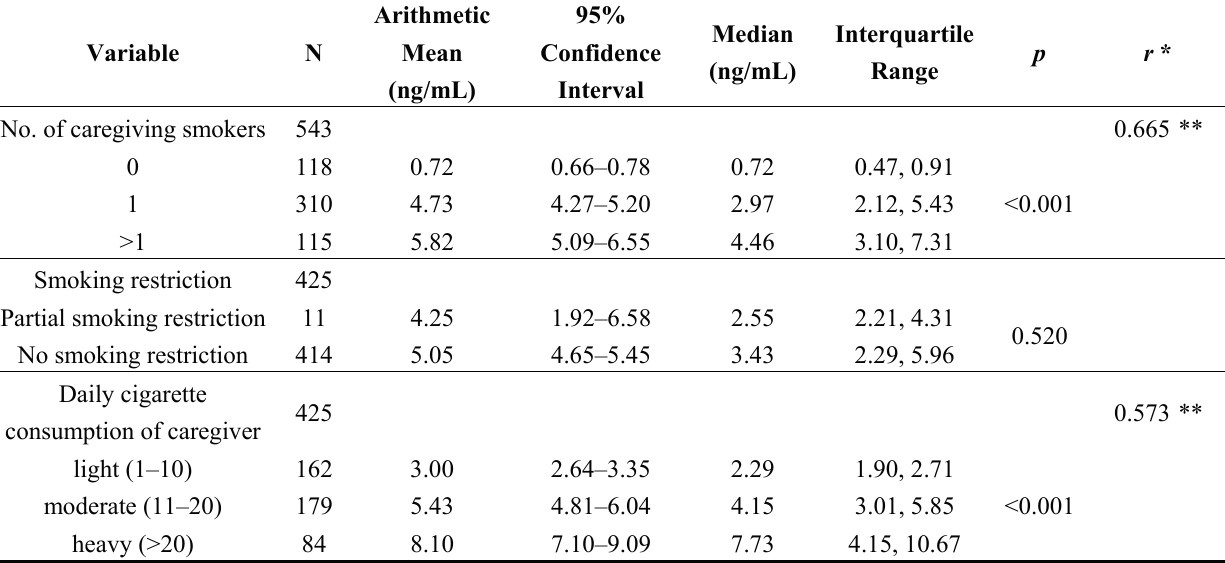
Table 2. Association between urinary cotinine levels with characteristics of environmental tobacco smoke according to the smoking behaviors of